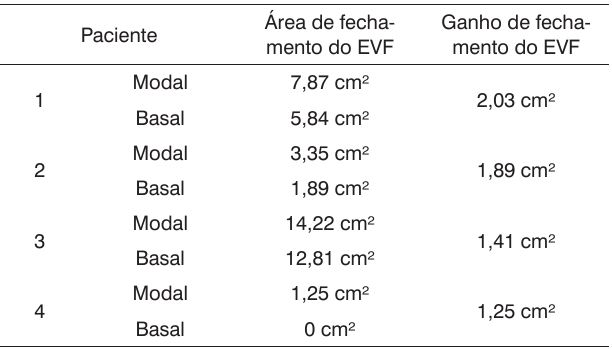
Tabela 3. Resultados da área de fechamento velofaríngeo, calcula- do pelo programa Vector